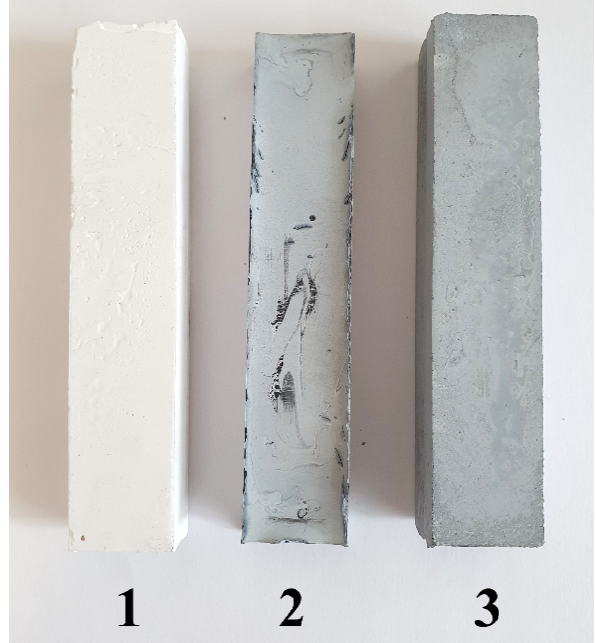
Figure 2. Photograph of prepared prismatic specimens of ( 1 ) MOC-REF (a reference sample with pure Magnesium Oxychloride Cement), ( 2 ) MOC-G (Magnesium Oxychloride Cement with Graphene), and ( 3 ) MOC-G-H (Magnesium Oxychloride Cement with Graphene Homogenized by Ultra-Turrax).